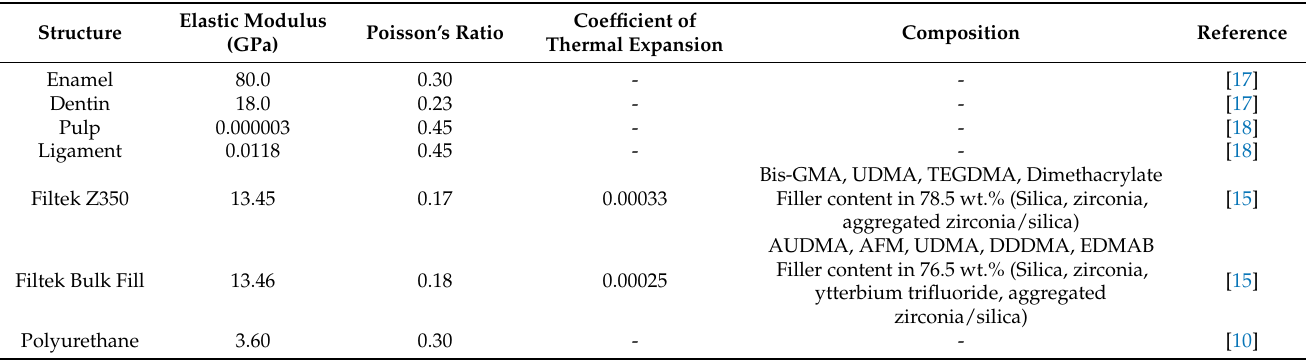
Figure 4. FEA Maximum Principal Stress results in the direct access design. ( a ) Bulk-fill flowable and ( b ) Conventional.